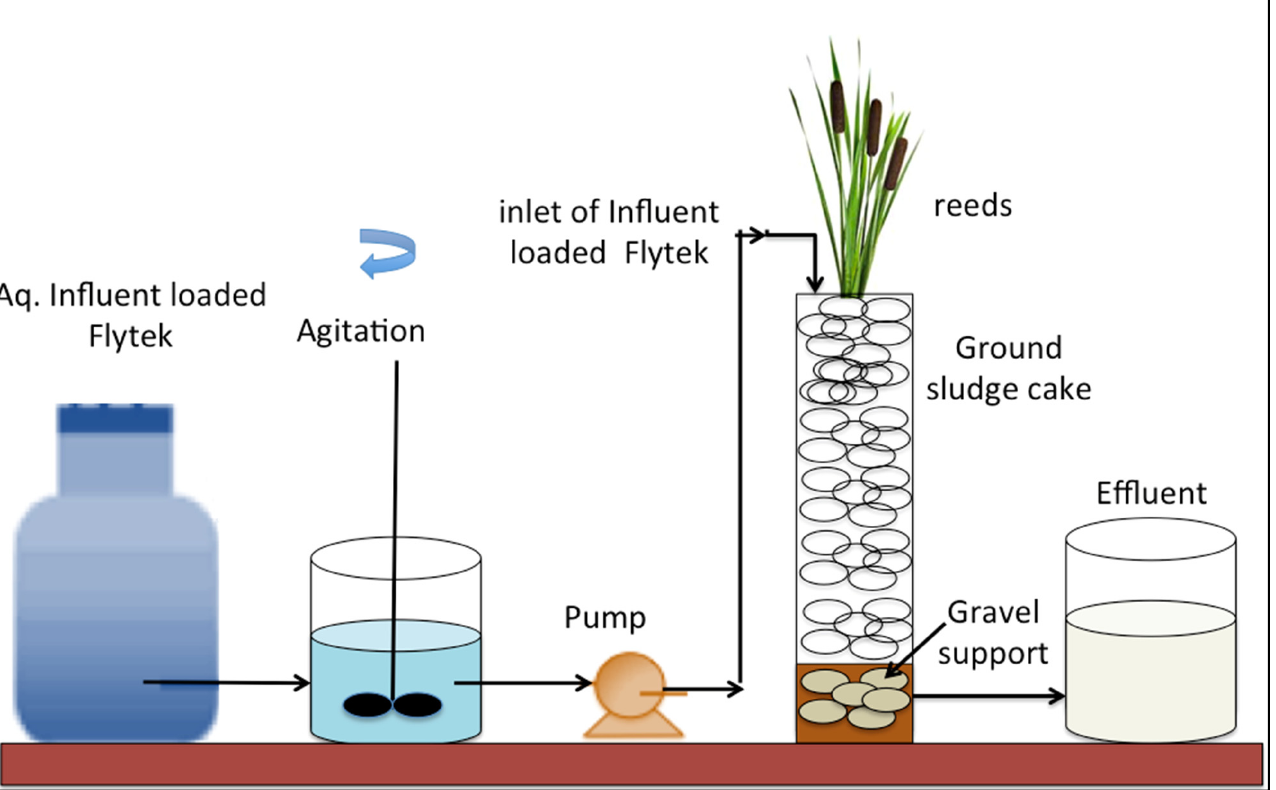
Figure 1. Systematic representation of the experimental technique.